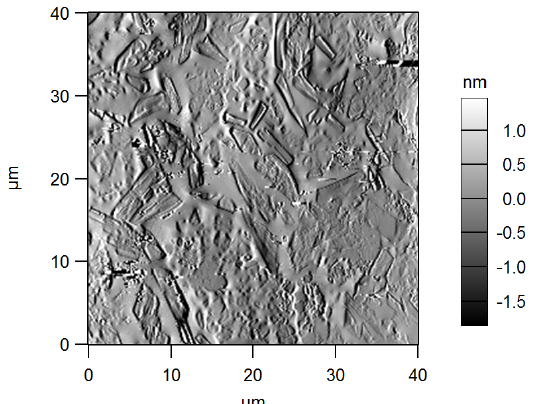
Figure 4. Image of additional data channel taken by AFM on GCA, simultaneously with the height one in Figure 3e: the scale reports the mean deviation in oscillation amplitude between trace and retrace scan.